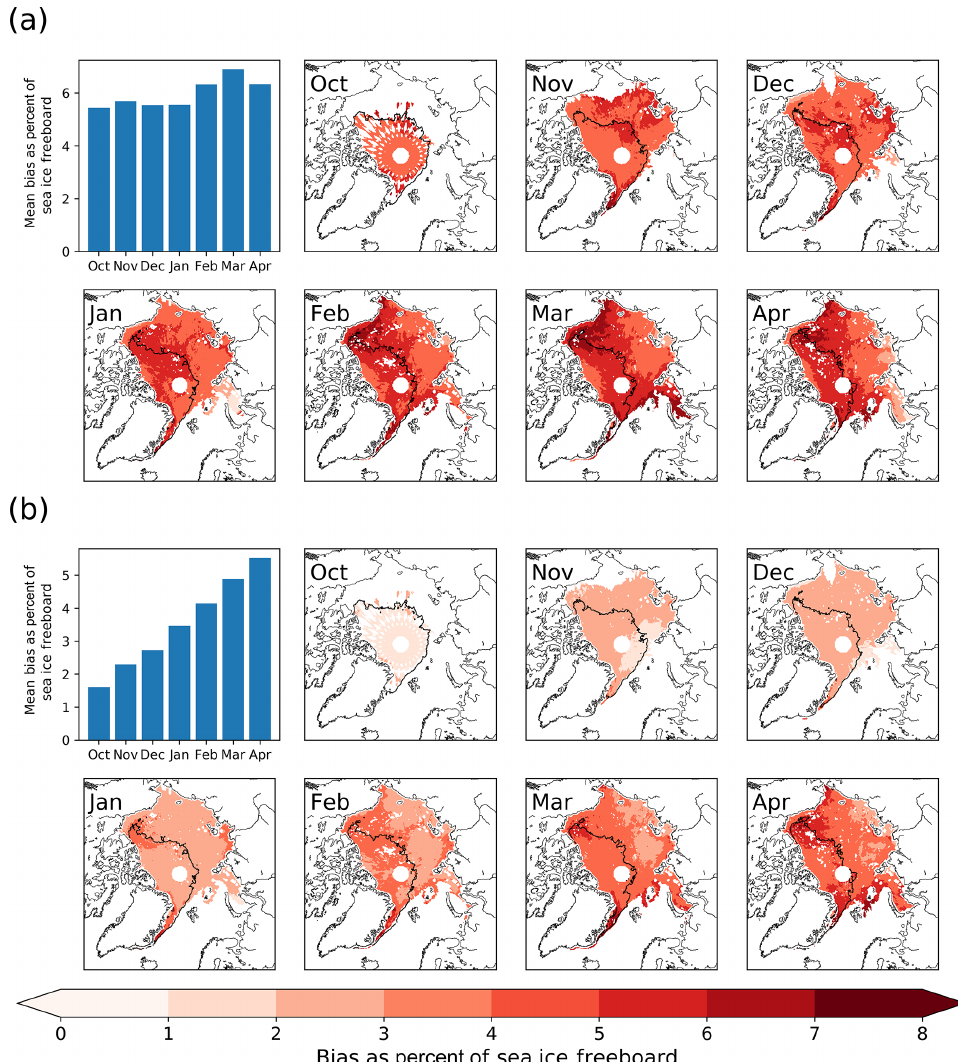
Figure 3. Percentage bias in sea ice freeboard. The bias induced by two effects was compared to the radar freeboards processed using the assumptions of Landy et al. (2019). (a) Percentage bias introduced by the use of Eqs. (5) vs. (6) when combined with the W99 fits for depth and density. As a fraction of the growing ice freeboard, biases remain relatively constant, indicating they grow at the same rate. (b) Percentage bias introduced by an evolving snow density derived from W99 data. This bias increases as a fraction of the ice freeboard from 2.3% to > 6%, indicating that thermodynamic growth rates are